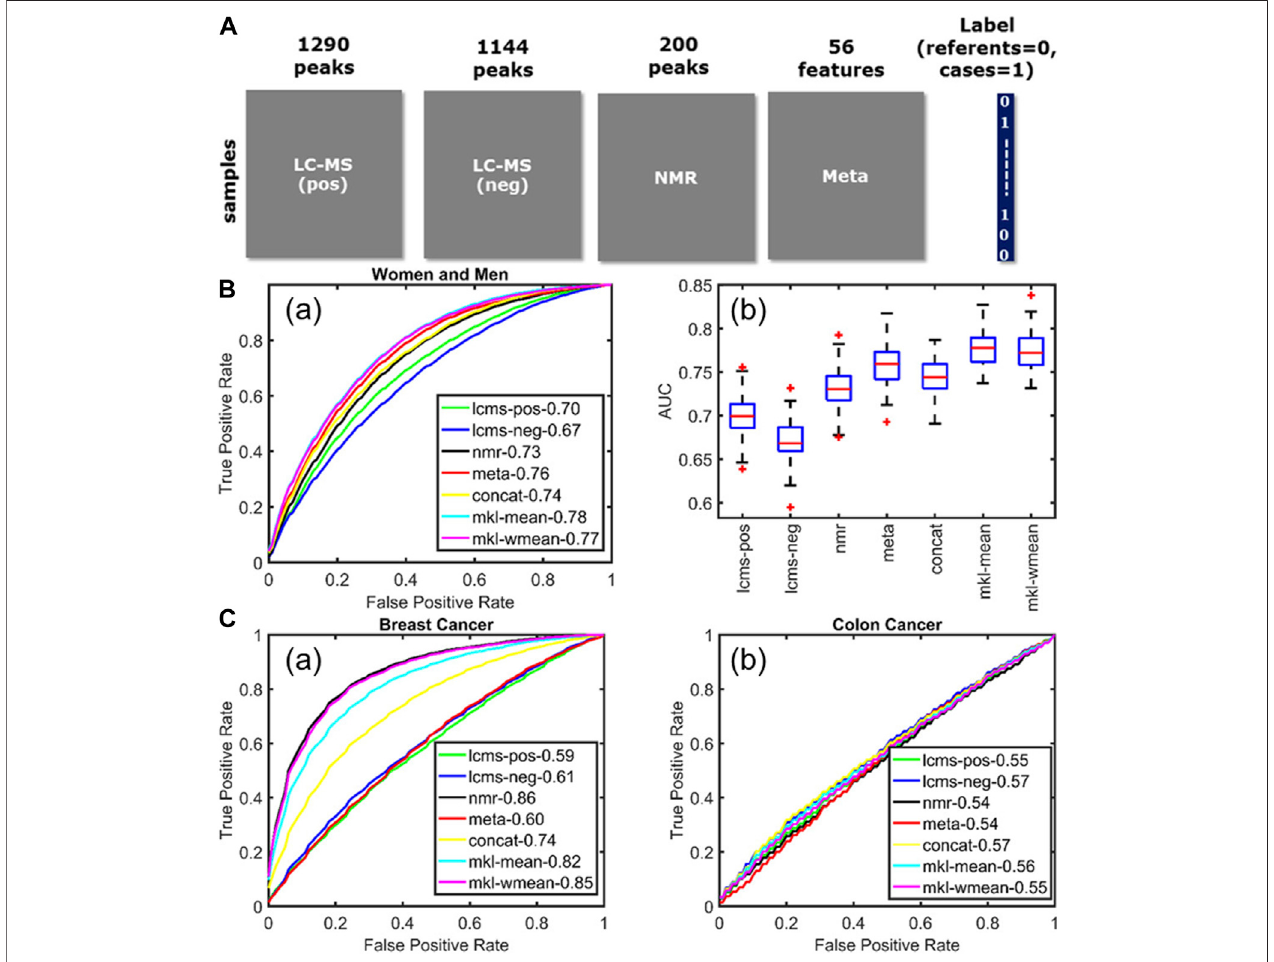
FIGURE 5 | Multiblock data fusion applied to study the metabolic alterations in human plasma samples from patient suffering from chronic diseases. (A) Data sets used in this study: metabolomics measurements (LC – MS and NMR), the metadata set containing life-style information, and the label information corresponding to each sample. (B) Acute coronary syndrome. (a) Average ROC curves showing the forecasting performance of individual data sets as well as fusion methods for women and men. (b) Boxplots summarize the performance of different approaches across 100 training/test sets. (C) Average ROC curves illustrating the forecasting performance of (a) breast cancer and (b) colon cancer. Figure reproduced with permission from (Acar et al., 2017).